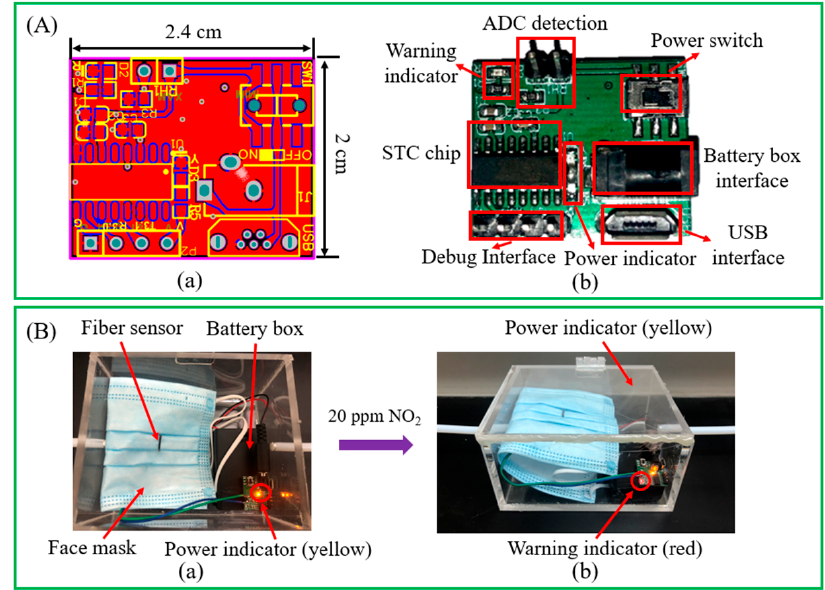
Figure 9. ( A ) Over-limit warning node module: ( a ) PCB; and ( b ) image of the physical system. ( B ) Working condition of the wearable sensor’s early warning system in ( a ) a normal gas environment; and ( b ) 20 ppm NO 2 gas.